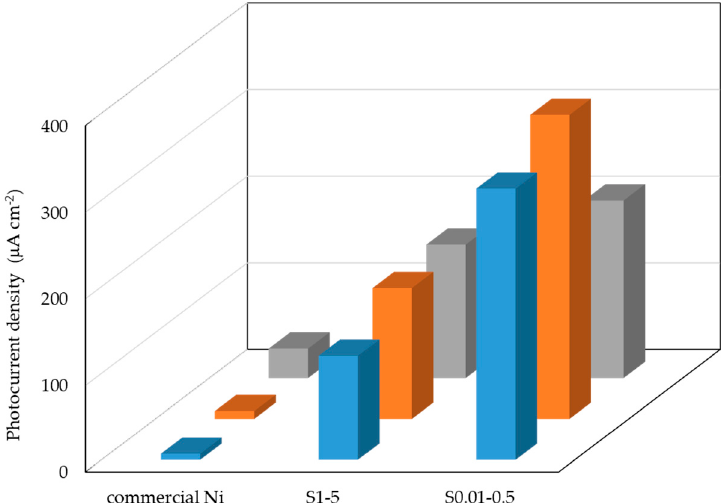
Figure 8. Cathodic photocurrent density recorded in KNO 3 0.1 M solution for di ff erent samples, at di ff erent applied potential: − 0.4 V (blue bars), − 0.6 V (orange bars) and − 0.8 V (grey bars).